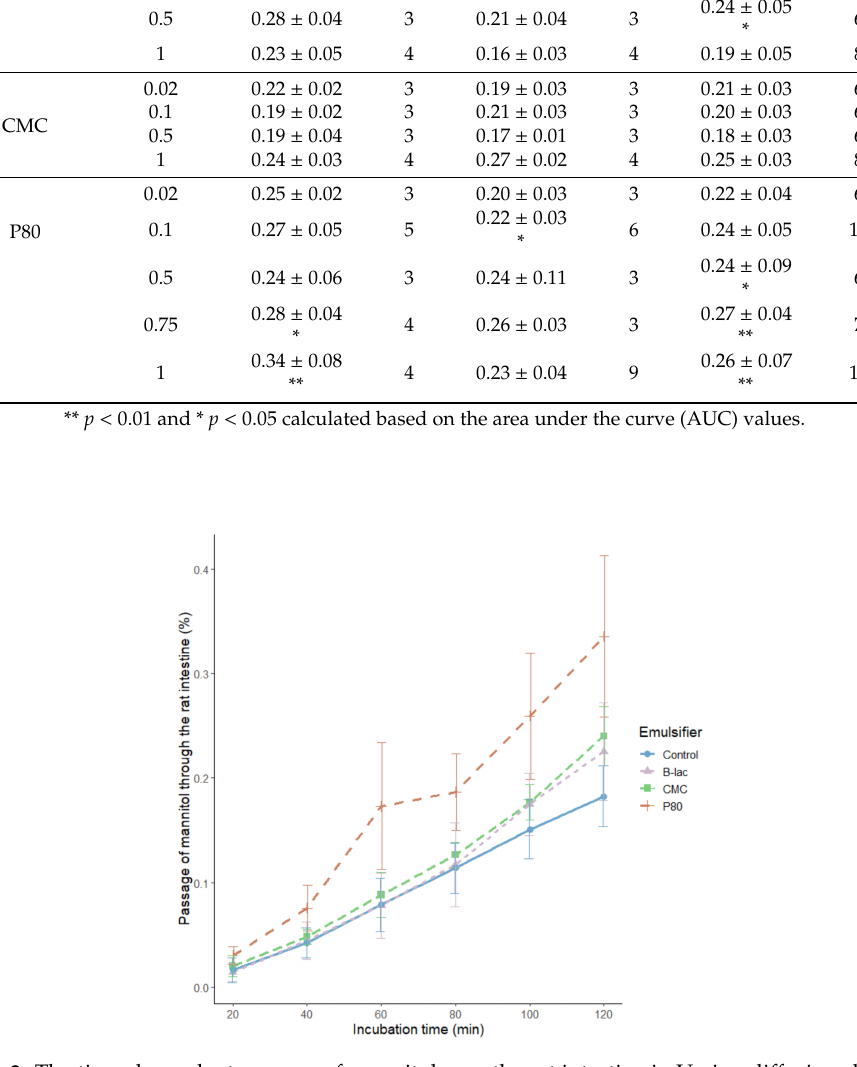
Figure 3. The time-dependent passage of mannitol over the rat intestine in Ussing di ff usion chambers (% of the amount added to the mucosal half-cell). The rat intestine was incubated with emulsifiers (1% P80 ( n = 13), 1% CMC ( n = 8), and 1% beta-lactoglobulin ( n = 8)) on the mucosal side for 2 h. Values are represented as mean values, with their corresponding standard error as vertical bars. The increase in the passage induced by 1% P80 was significantly higher than for 1% CMC ( p = 0.02) and for 1% β -lactoglobulin ( p = 0.02) calculated based on the